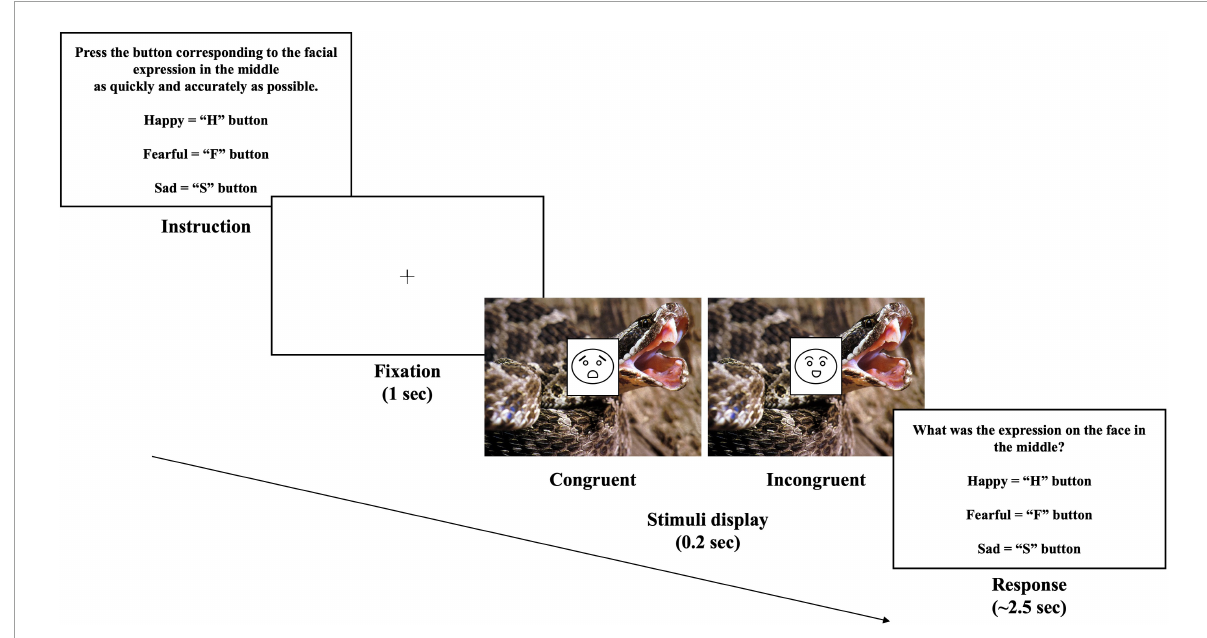
FIGURE1 Trial example of the overlap-emotional Task. The stimuli were presented under the condition of congruence or incongruence. The original stimuli are unable to be reproduced for copyright reasons but are available upon request from the corresponding